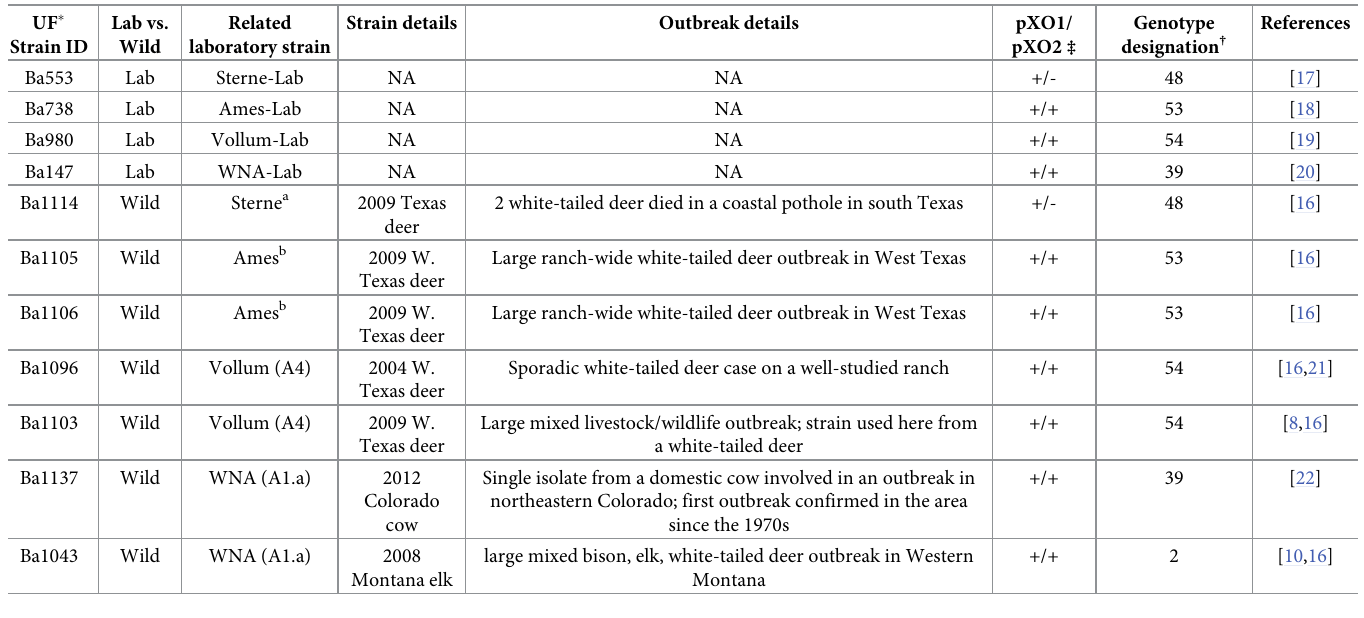
Table 1. Details of B . anthracis strains used in this study. UF � Lab vs. Strain ID